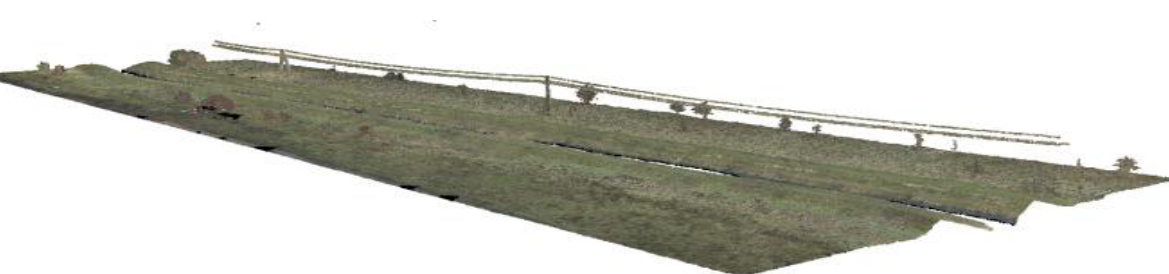
Figure 10. A colour point cloud from an ultra-light scanner, acquired from the UAV and coloured using photographs acquired from low